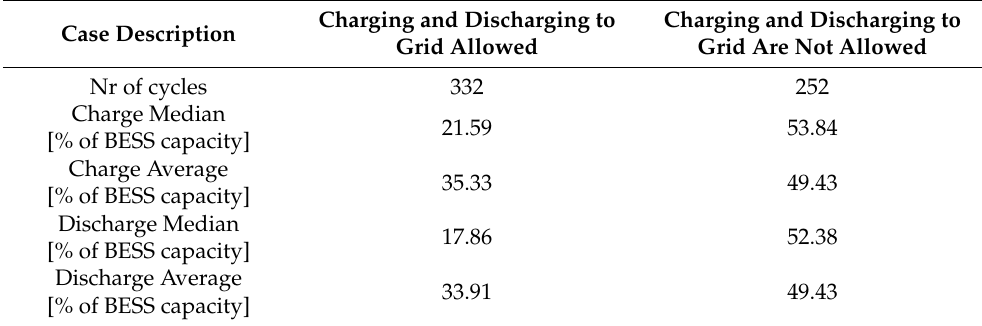
Table 4. Analysis of BESS charging and discharging cycles during the EC+LSC scenario for the cases of charging and discharging to the grid prohibited and